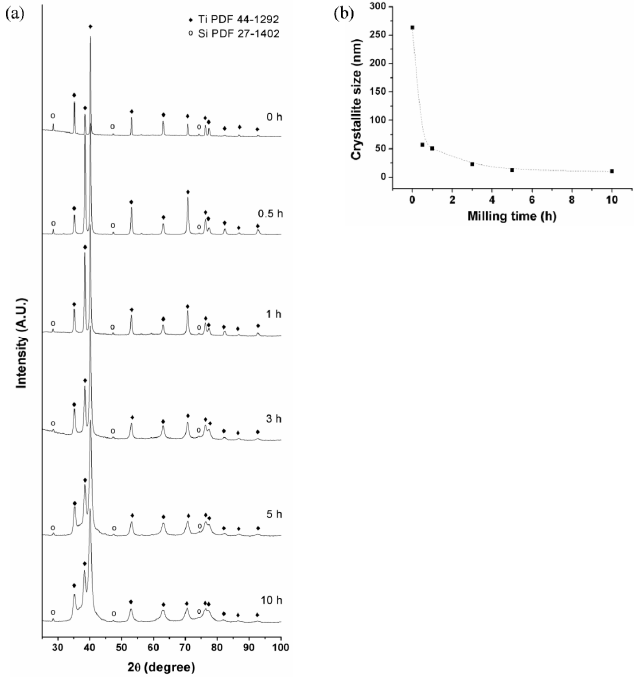
Figure 2. ( a ) XRD patterns of mechanically alloyed powders; ( b ) crystallite size as function of milling